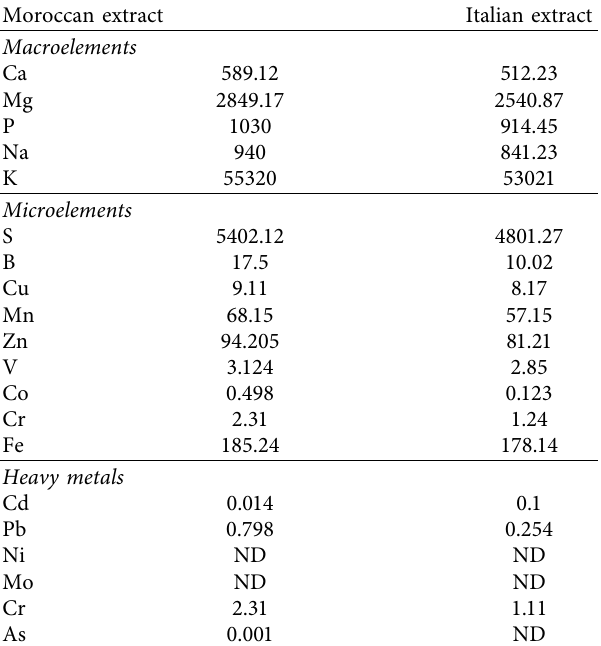
Table 2: Mineral contents in mg/Kg dw of C. sativus aqueous extracts.